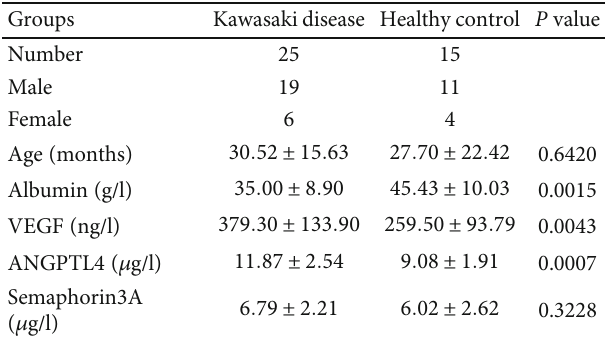
Table 1: Comparison of baseline characteristics between KD patients and healthy